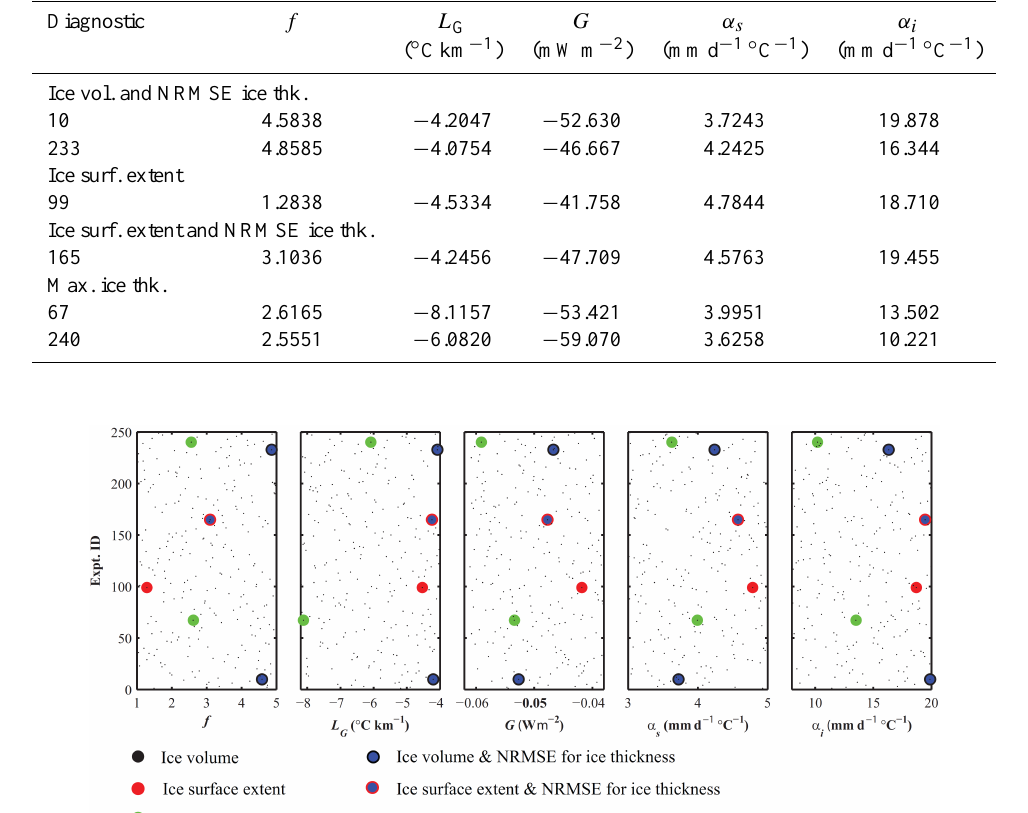
Table 5. Tuned parameter values for the six optimal experiments chosen according to diagnostic skill score identified by their experiment number.